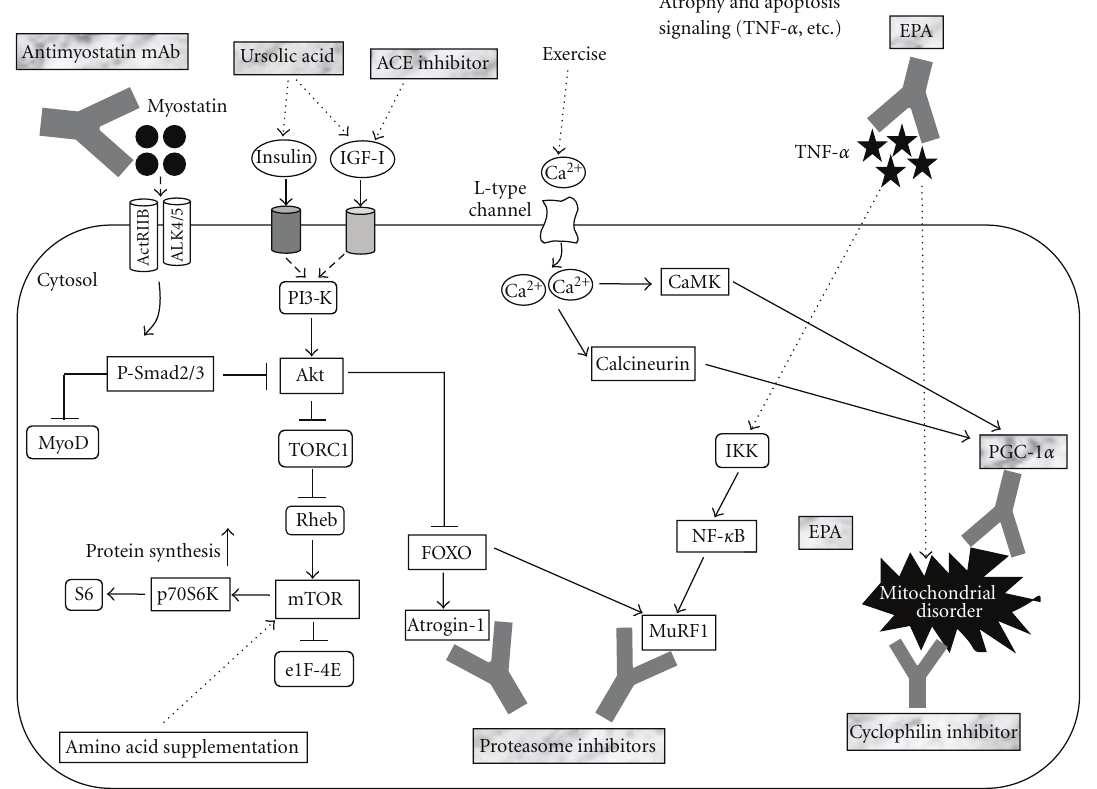
Figure 1: Myostatin signals through the ActRIIB-ALK4/5 heterodimer activate Smad2/3 with blocking of MyoD transactivation in an autoregulatory feedback loop. In addition, Smad3 sequesters MyoD in the cytoplasm to prevent it from entering the nucleus and activating the stem cell population. Recent findings [105, 106] have suggested that myostatin-Smad pathway inhibits protein synthesis probably due to blocking the functional role of Akt. Supplementation with ursolic acid upregulates the amount of IGF-I and insulin and then stimulates protein synthesis by activating Akt/mTOR/p70S6K pathway [29]. Treatment with ACE inhibitor also enhances IGF-I level in muscle. Amino acid supplementation enhances protein synthesis by stimulating mTOR [107]. Akt blocks the nuclear translocation of FOXO to inhibit the expression of Atrogin-1 and MuRF1 and the consequent protein degradation. Proteasome inhibitors combat the ubiquitin-proteasome signaling activated by these atrogenes. In cachexic muscle, supplementation with EPA downregulates the amount of TNF- α and NF- κ B [63, 64]. Endurance exercise increases the amount of PGC-1 α through calcineurin- or CaMK-dependent signaling [108]. Both activated PGC-1 α , and cyclophilin inhibitor protects several mitochondrial disorders (apoptosis, oxidative damage, etc.) elicited by the increase in NF- κ B and Bax and/or the decrease in Bcl-2 in senescent muscle. ACE; angiotensin-converting enzyme, ActRIIB; activin receptor IIB, ALK4/5; activin-like kinase 4/5, CaMK; calmodulin kinase, eIF4E; eukaryotic initiation factor 4E, EPA; eicosapentaenoic acid, FOXO; Forkhead box